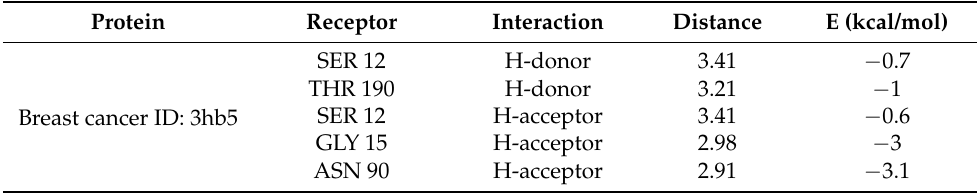
Table 7. Binding energy of the interaction with Ag- Complex.